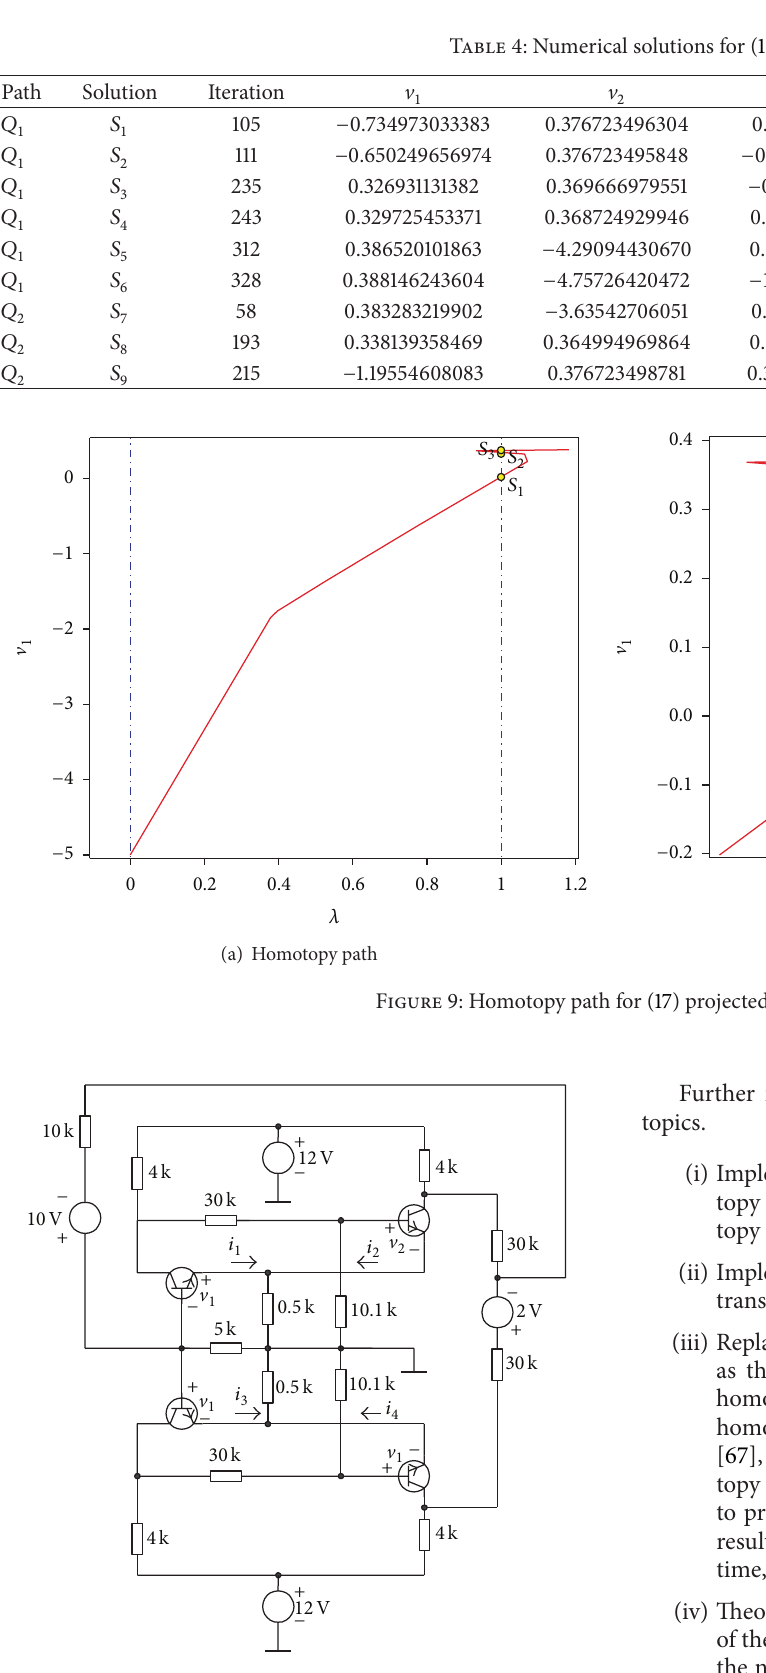
Figure 10: Chua’s circuit with nine